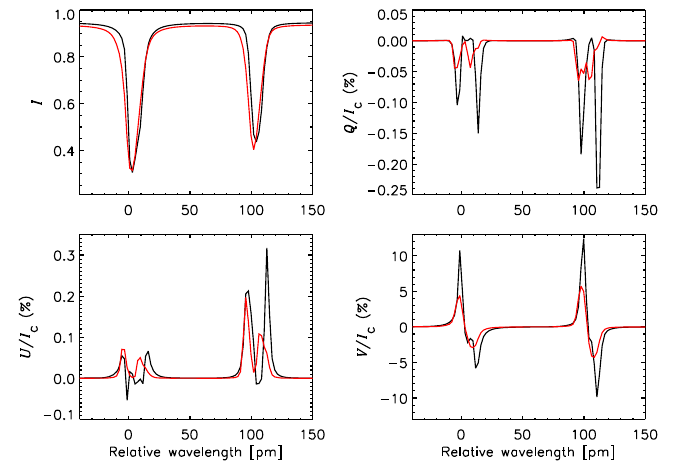
Fig. 4 Example of the effects of telescope diffraction on the asymmetries of the Stokes profiles emerging from an MHD model with mean field strength of 10 G. The selected pixel is located in an intergranular lane. The degradation corresponds to the Hinode PSF. Black and red are used to show the original and degraded profiles, respectively. From Orozco Suárez (2008)